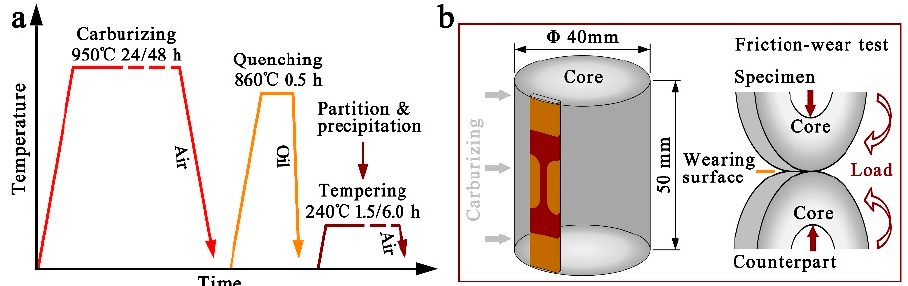
Figure 1. ( a ) is a schematic diagram of the carburizing–quenching–tempering treatment; ( b ) shows the specimen for carburization with the sampling position for tensile test and a sketch of friction-wear test for evaluating wear resistance.